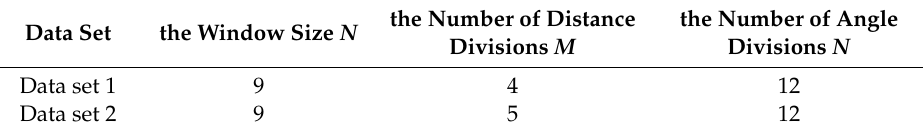
Table 2. The parameters of proposed method in the experiments.